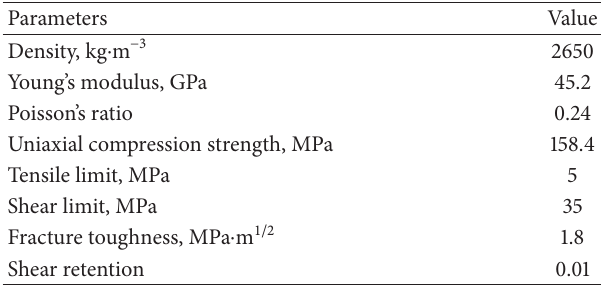
Table 1: Input parameters for the rock model.